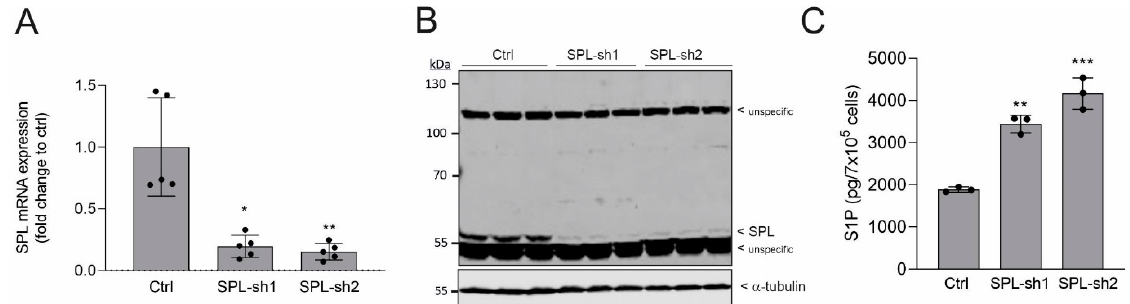
Figure 1. Characterization of stable SPL knockdown in human podocytes. Human podocytes that were stably transduced with an empty vector (Ctrl) or two different SPL shRNA constructs (SPL-sh1: TRCN0000078314; SPL-sh2: TRCN0000286832: further denoted as SPL-kd) were differentiated to mature podocytes for 5 days at 37 °C, then incubated for 4 h in serum-free medium. ( A ) RNA extracts were taken for quantitative PCR analysis of human SPL and 18S RNA for normalization. Data show the mRNA expression of SPL (Sgpl1) as a fold change, with means ± SD ( n = 5). ( B ) Protein extracts were taken for SDS-PAGE, transferred to nitrocellulose, and subjected to Western blot analysis, using an antibody against SPL (dilution 1:1000, upper panel, SPL at 59 kDa) and α -tubulin for normalization (1:3000, lower panel). ( C ) Ctrl and SPL-kd cells were taken for lipid extraction and the mass spectrometric quantification of S1P. Data show cellular S1P concentrations and are expressed as pg/7 × 10 5 cells, with means ± SD ( n = 3). * p < 0.05, ** p < 0.01, *** p < 0.001 are considered statistically significant when compared to the Ctrl samples.